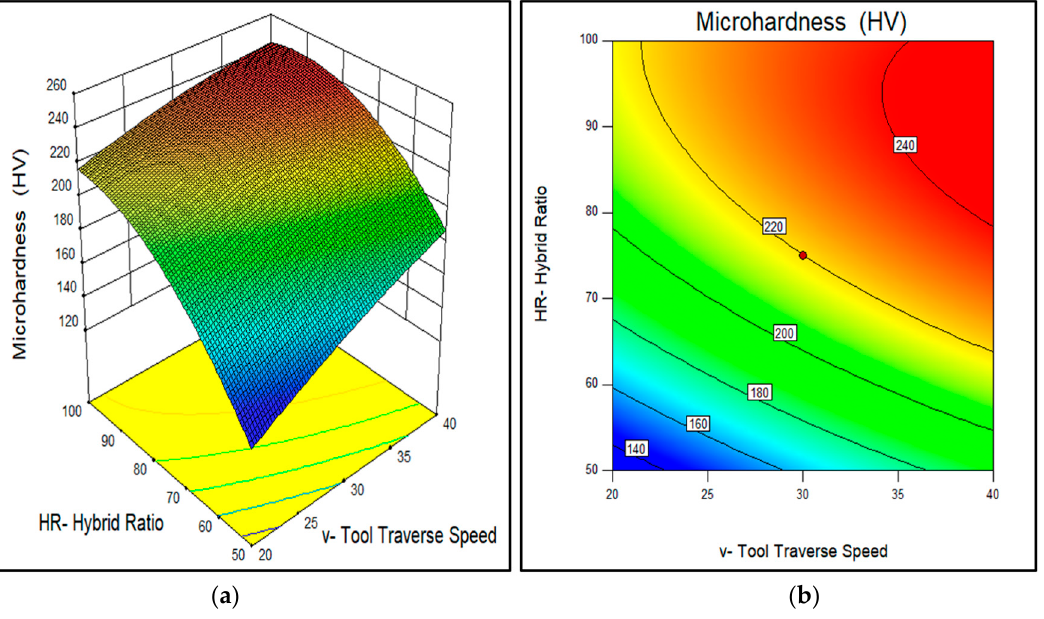
Figure 14. Effect of tool traverse speed and hybrid ratio on the wear rate of AA7075-SiC/fly ash composites ( a ) 3D surface and ( b ) contour plot.